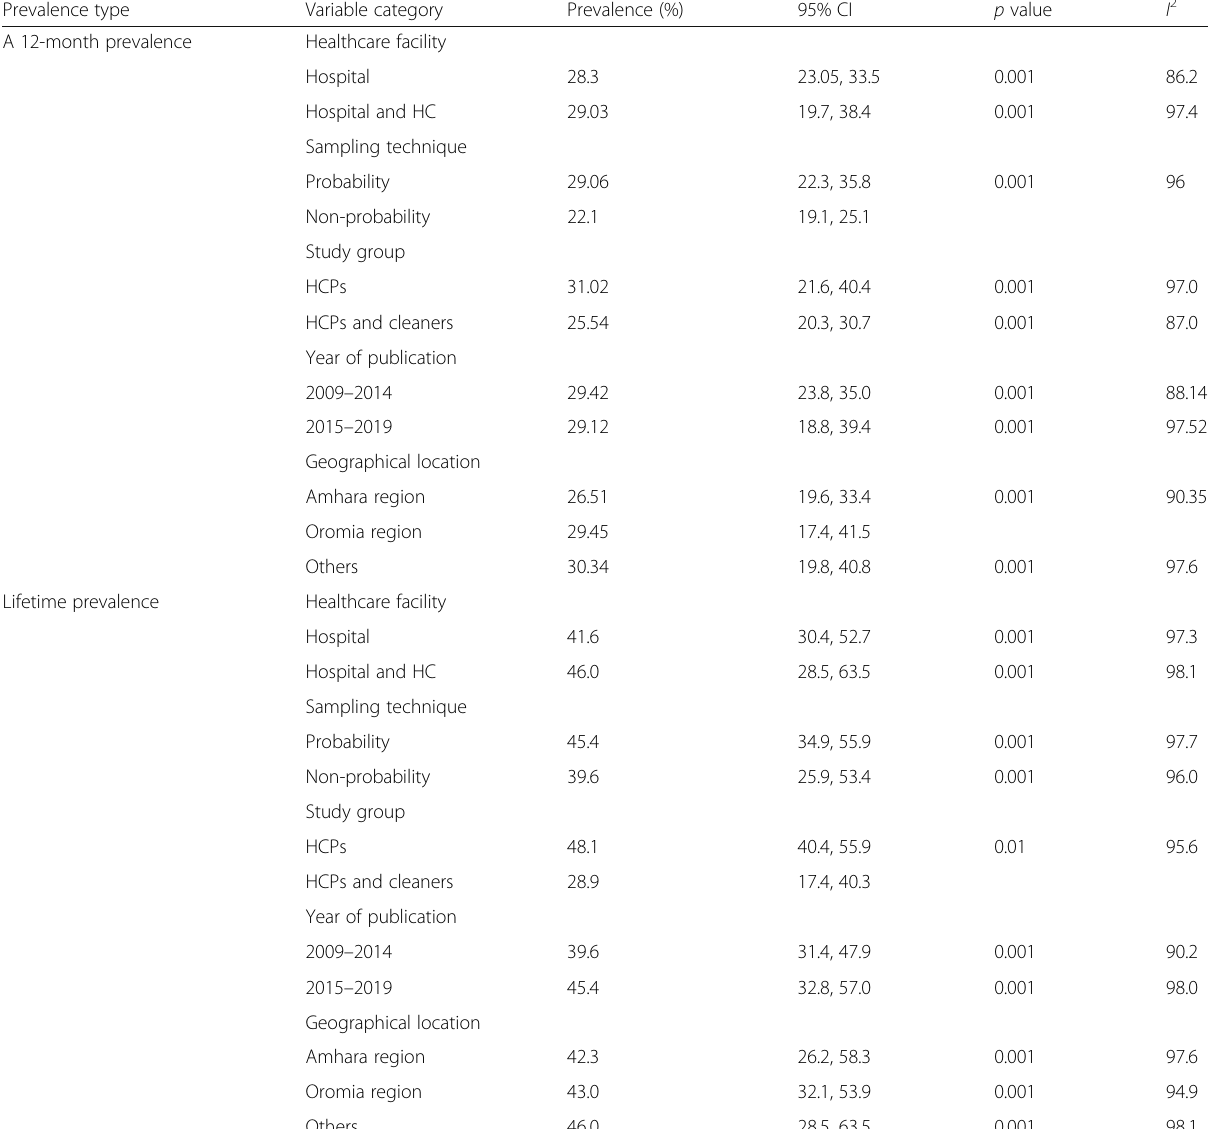
Table 2 Subgroup analysis of the prevalence of 12 months and lifetime needlestick injuries among the Ethiopian healthcare workers, 2019